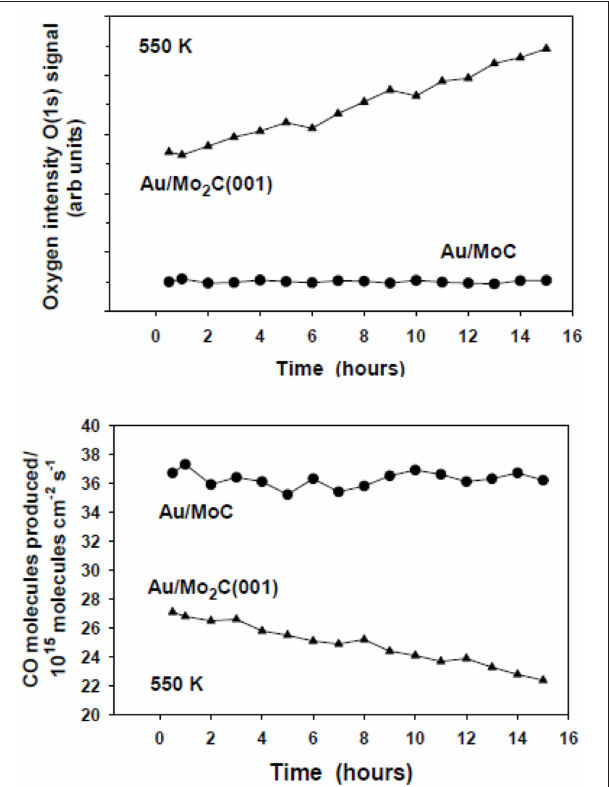
FIGURE 14 | Top: Coverages of O measured with XPS for Au/ β -Mo 2 C(001) and Au/ δ -MoC catalysts ( θ Au ∼ 0.2ML) as a function of time under constant CO 2 hydrogenation conditions. Bottom: Corresponding rate of CO generation over the Au/ β -Mo 2 C(001) and Au/ δ -MoC catalysts as a function of time maintaining the same reaction mixture. In a batch reactor, both catalysts were exposed to 0.049 MPa (0.5 atm) of CO 2 and 0.441 MPa (4.5 atm) of H 2 at a temperature of 550K. Reproduced with permission from Posada-Pérez et al. (2016), copyright 2016 by the American Chemical